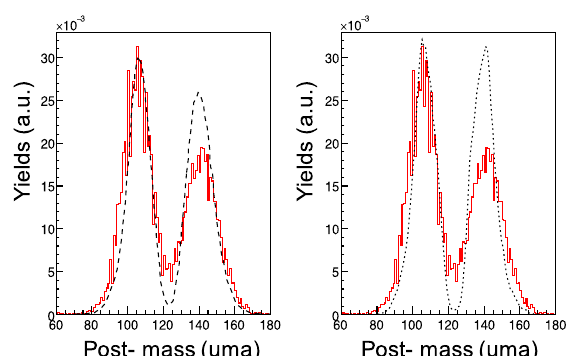
Fig. 3. 252 Cf FALSTAFF fragment mass distribution (red curve) is compared to VERDI (left panel) and SPIDER (right panel) results.